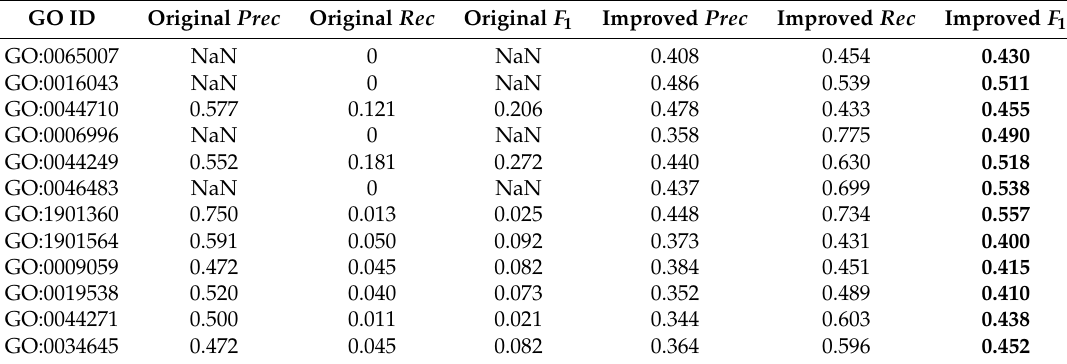
Table 2. The experimental results for specific